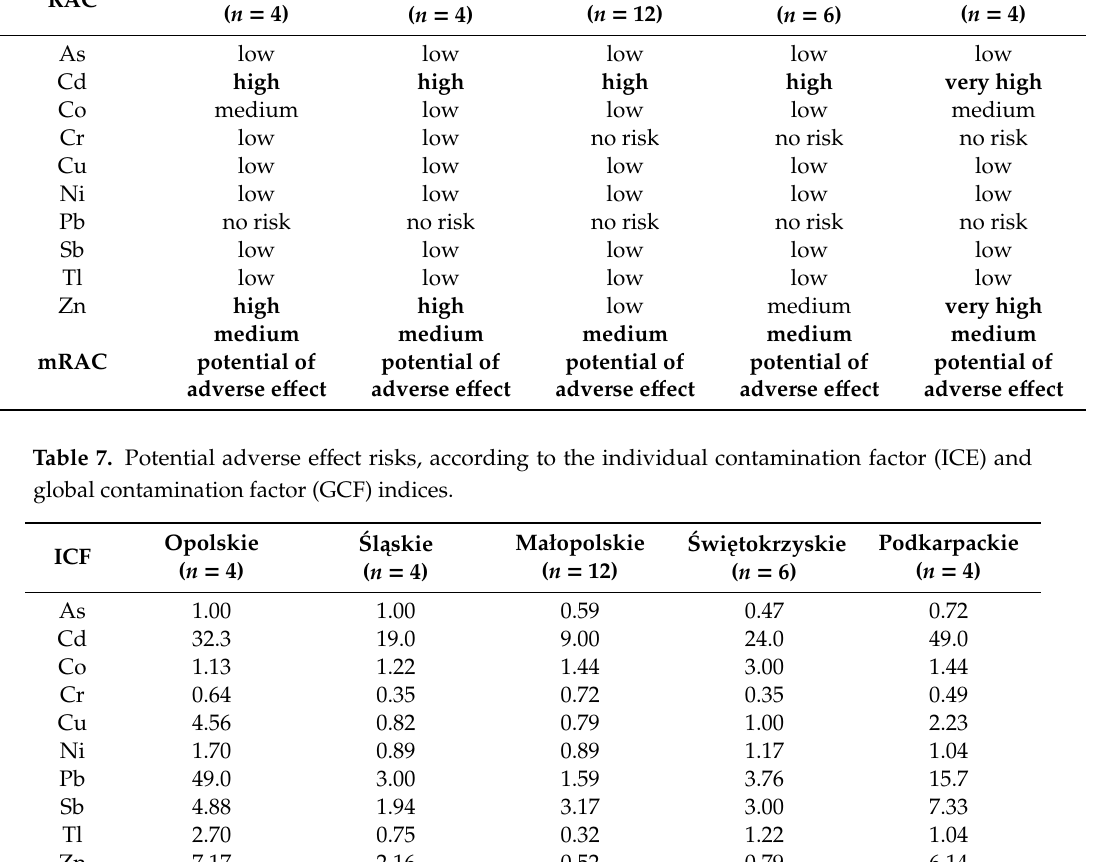
(Table 7) arranged PHEs in the following decreasing order of potential adverse e ff ect risks: Opolskie: